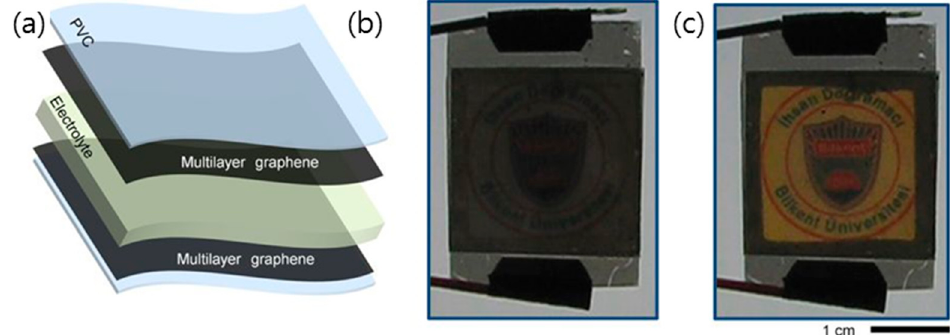
Figure 14. ( a ) Exploded-view illustration of the graphene electrochromic device. The device is formed by attaching two graphene coated polyvinyl chloride (PVC) substrates face to face and imposing ionic liquid in the gap separating the graphene electrodes. ( b , c ), Photographs of the devices under applied bias voltages of 0 V and 5 V, respectively. Reproduced with the permission of Reference [140]. Copyright 2014, Nature Publishing